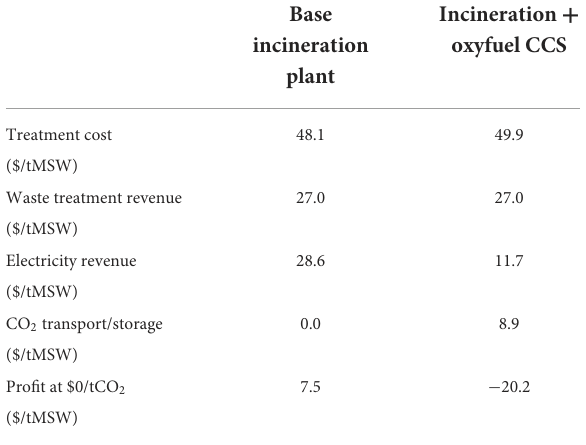
TABLE 2 Data used to generate plots for Case 1, based on data from Tang and You (2018).